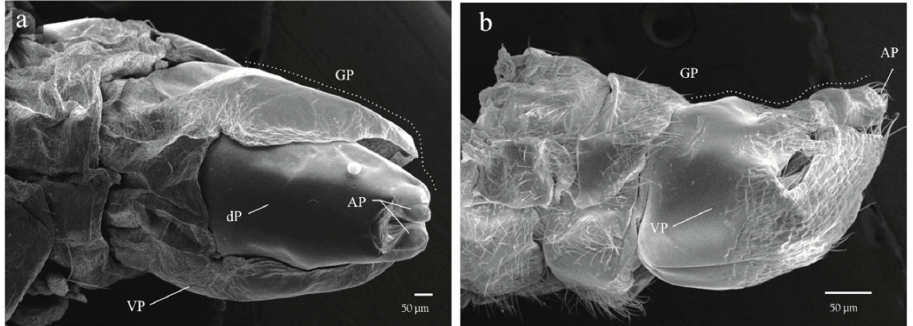
Figure 8. Antennae of the immature sages of Ocoaxo assimilis , corresponding to nymphal instar one to five (NI–NV). a) NI. b) NII, c) NIII, 21) NIV, d) NVa, and e,f) NVb. FL (flagellum), P (pedicel), S (scape). The number in antennal segments indicate the number of Figure 9. Apical portion of the abdomen of Ocoaxo assimilis nymphal instars with genital plates on the terminal segment developed. a ) Male in dorsal view, showing two short apical processes with the ventral plate covering half of the dorsal plate, b ) female in lateral view with two pairs of acute processes with the ventral plate covering most of the dorsal plate. AP (apical processes), GP (genital plate), VP (ventral plate).